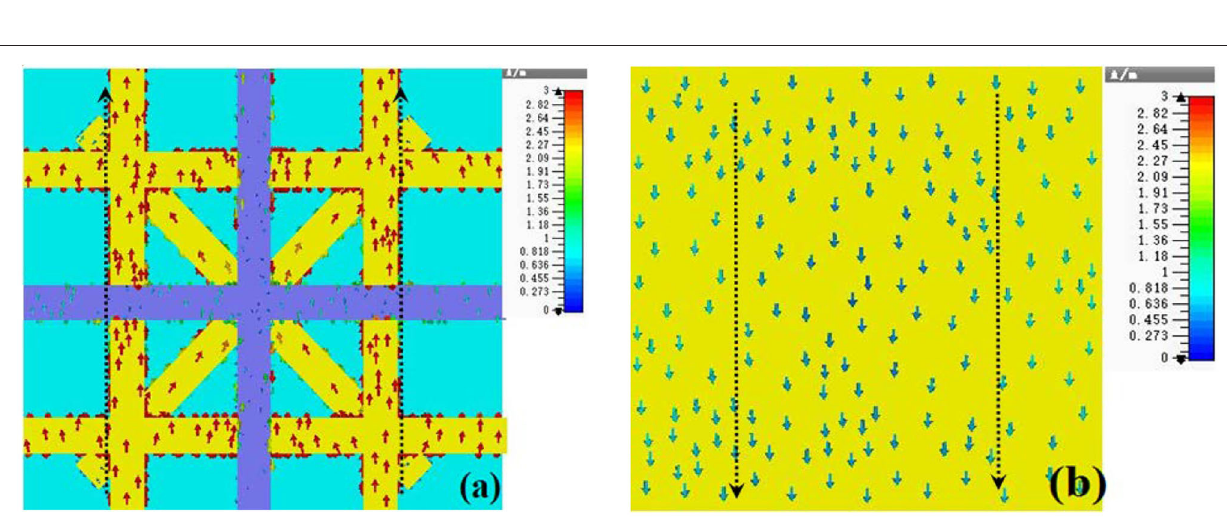
Frontiers in Physics |